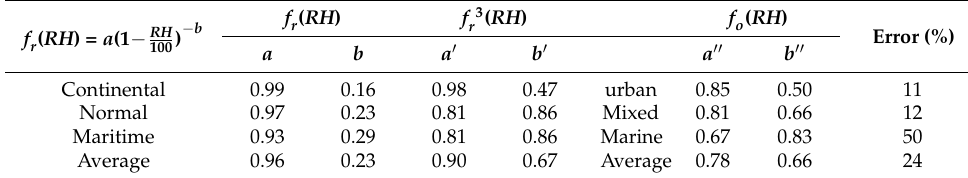
Table 6. Hygroscopic growth functions on particle radius (r) and particle extinction (o). The